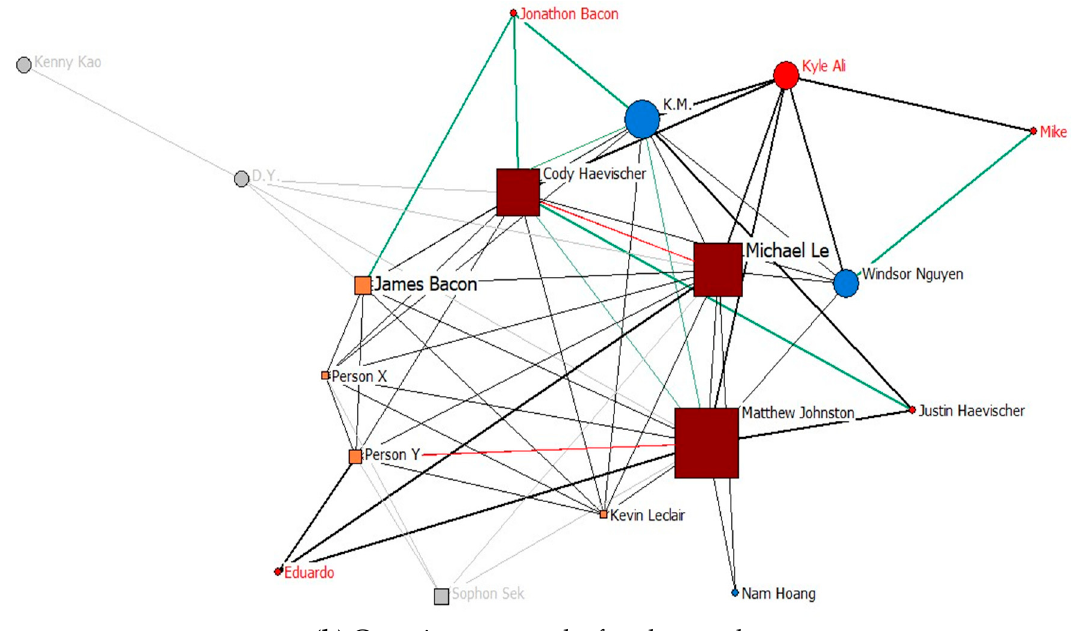
Figure 1. The Surrey Six Murder network before ( a ) and after ( b ) the murder. Notes. The squared nodes took part in the conspiracy, rounded nodes did not. The brown nodes represent the Asian side, while the orange nodes represent the White side. The black lines represent business ties, the green lines trust ties, and the red lines conflict ties. Leader names in bold. Node size by betweenness centrality. ( a ) The blue squared node was involved in the conspiracy but was not part of the Red Scorpions. ( b ) The gray nodes and lines stand for the nodes and ties that disappeared after the murder. The lines in bold and the red rounded nodes represent the ties and the nodes that appeared after the murder.